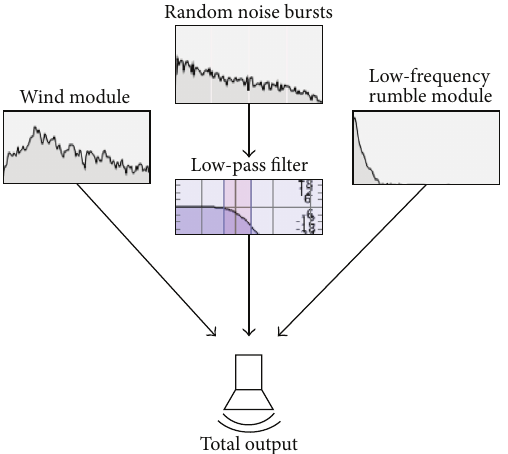
Figure8:Illustrationofthefourdifferentmodulesoftheprocedural skiing sound model.